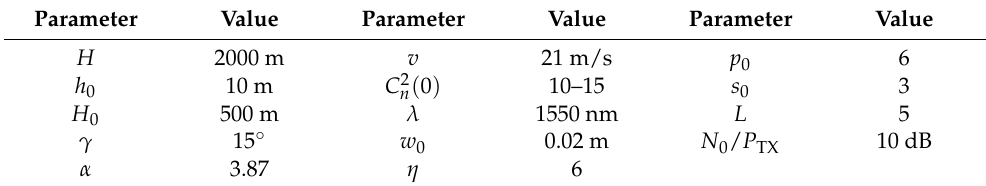
Table 1. Parameters setting the air–ground OAM communication system in the atmospheric turbulence. Parameter Value Parameter Value Parameter